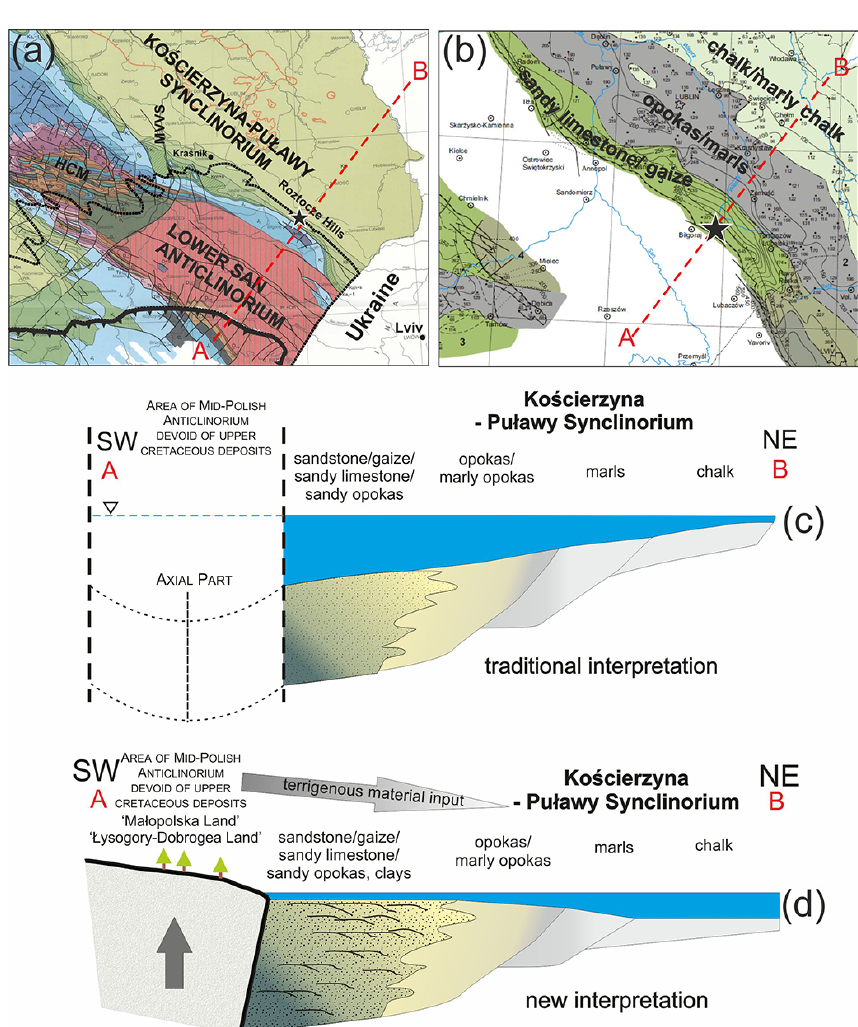
Figure 2. (a) A close-up view of the Roztocze Hills area, relative to the position of the Holy Cross Mountains and Lower San Anticlino- rium; (b) the general distribution of Campanian lithofacies in southeast Poland (adopted from ´Swidrowska, 2007) – sandy limestone: deep; chalk: shallow; red dashed line – an interpreted cross section of two competing tectonic concepts (c) and (d) ; (c) a facies and bathymetric sedimentation model based on traditional interpretations, assuming the deep-water character of deposits close to the axial part of the Mid- Polish Trough; vertical dashed-lines indicate areas devoid of Cretaceous deposits at present; (d) an alternative depositional, structural, and environmental interpretation of facies and bathymetry in a cross section perpendicular to the axis of the Mid-Polish Anticlinorium (adopted from Remin et al., 2015a; Walaszczyk and Remin,